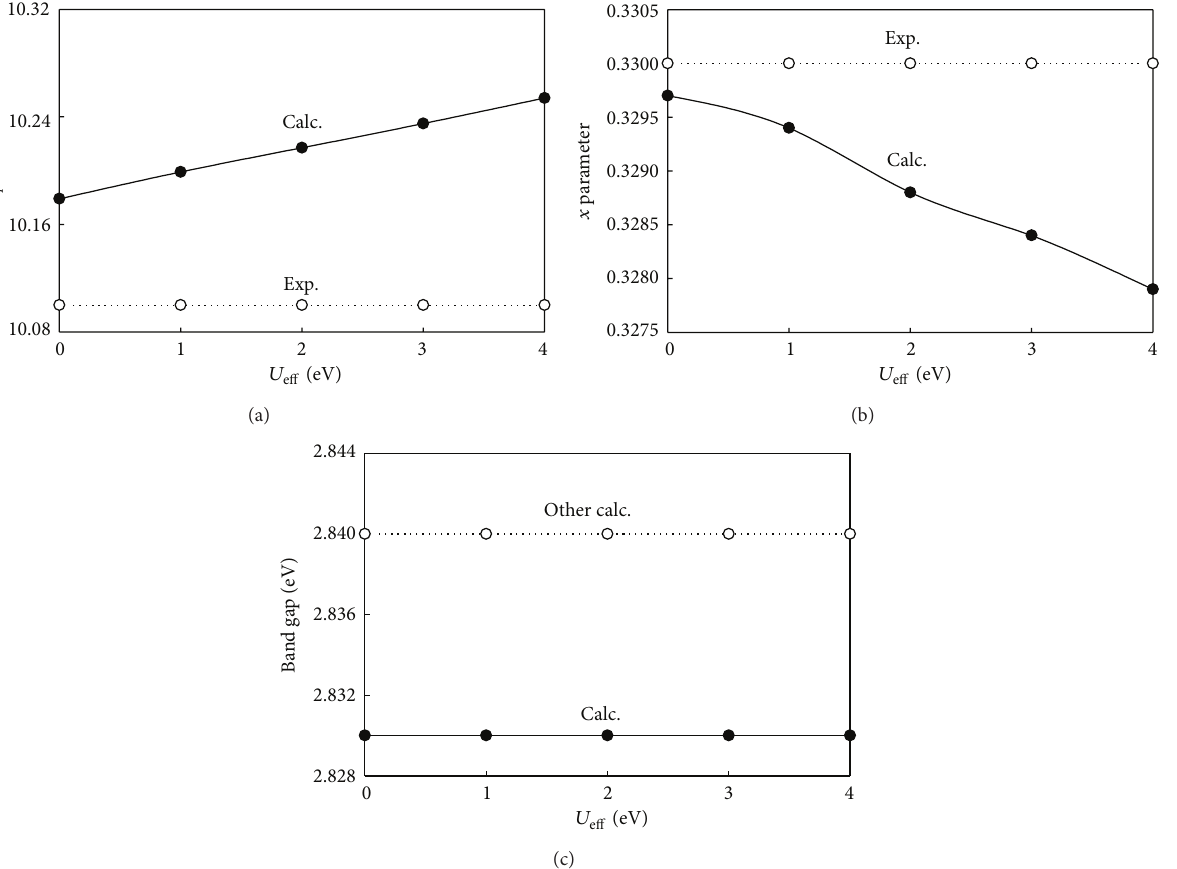
Figure 5: Dependence of the lattice parameter 𝑎 𝑝 (a), 𝑥 (b), and band gap (c) of the Y 2 Ti 2 O 7 on 𝑈